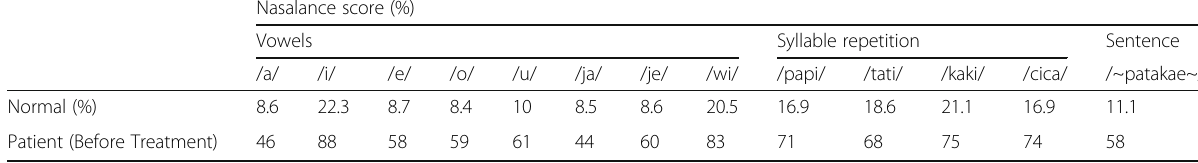
Table 1 Results of nasometric assessment of the patient before intervention